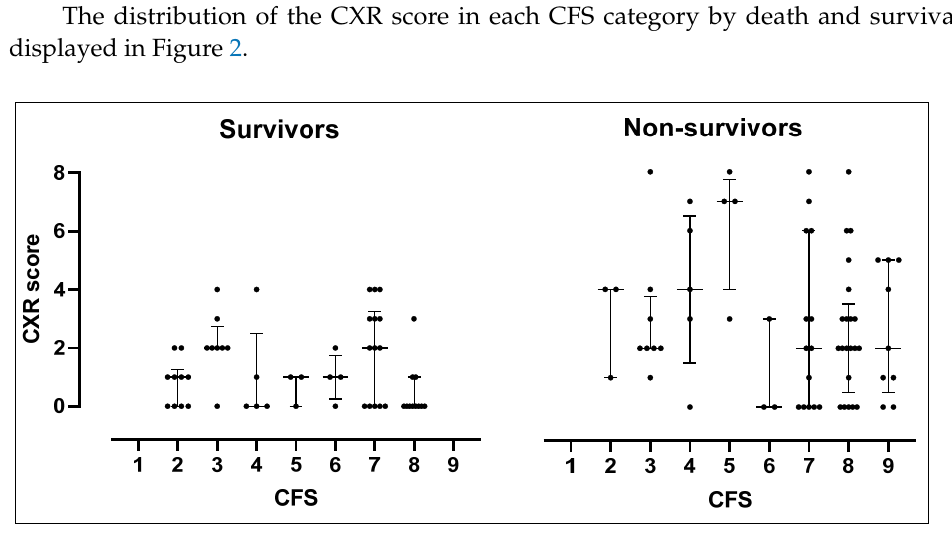
Table 3. Accuracy of the CXR score and net reclassification analysis for death during hospitalization.